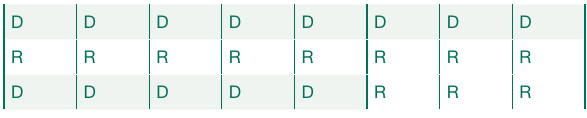
Figure 2 Correcting for gerrymandering in Wisconsin,